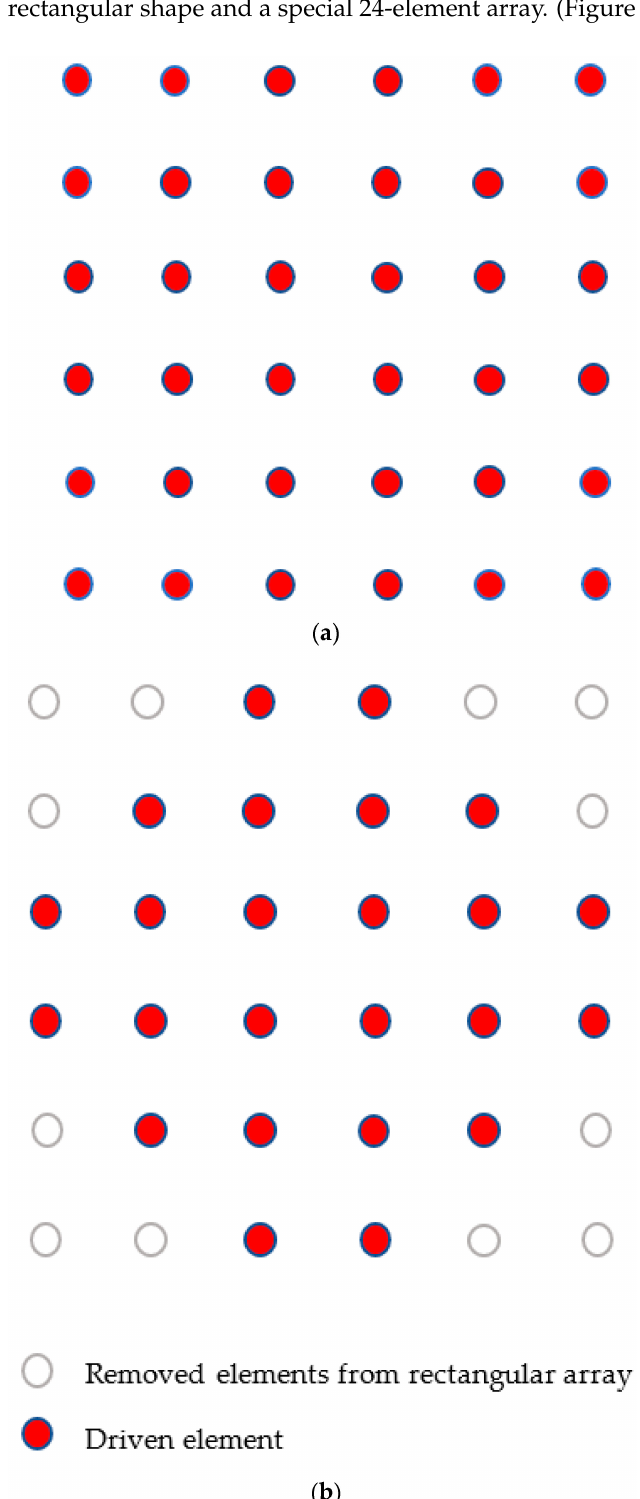
Figure 6. ( a ) A 6 × 6 planar uniform rectangular array. ( b ) 24-element